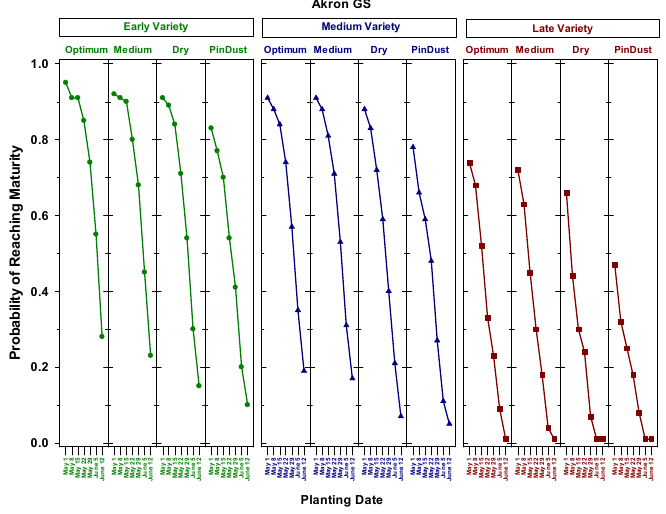
Figure 4. Probability of sorghum reaching physiological maturity at Akron, Colorado, for seven planting dates using non ‐ stressed (GS) phenological parameters, three maturity classes, and four seedbed water conditions at planting.